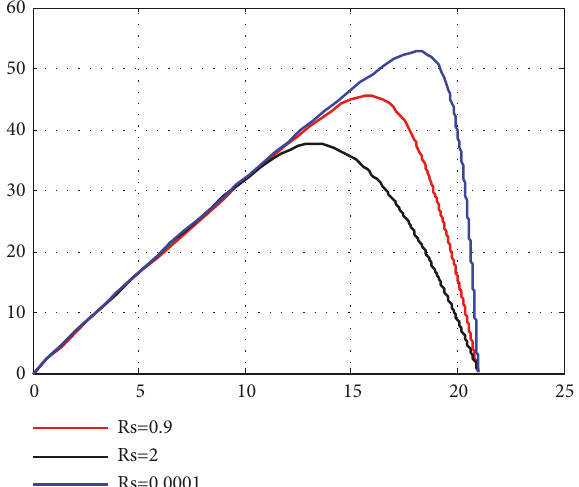
Figure 7: Influence of shunt resistance on the 𝑃 𝑝 V = 𝑓(𝑉 𝑝 V )